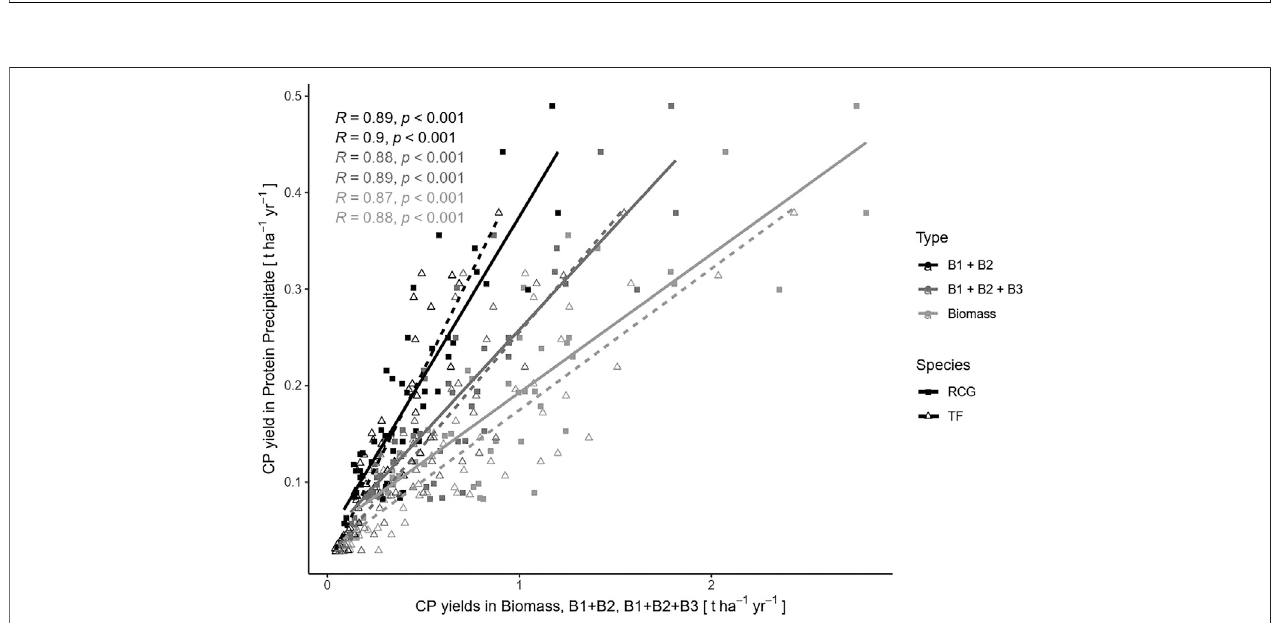
FIGURE 7 | Process fl owchart of the biore fi nery screw-press technique, indicating dry matter (DM) and crude protein (CP) contents relative to the biomass input. Magnitudes ofdrymatterlosses during processing are given at the twostages. Contents ofdry matter (g kg − 1 fresh weight) and crude protein (g kg − 1 dry matter) for the various fractions and treatments on different harvest dates are provided in the supplementary material for reed canary grass ( Supplementary Table S3 ) and tall fescue ( Supplementary Table S4 ).